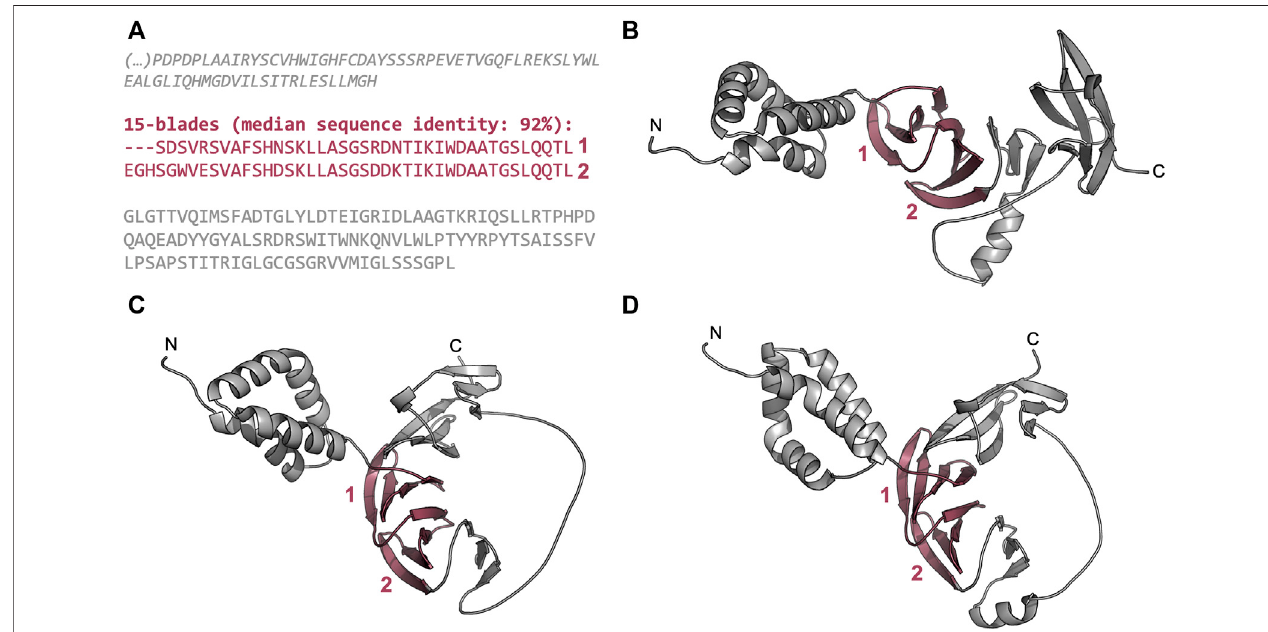
FIGURE 7 | The globally highly repetitive β -propeller of Menosporascus sp. CRB-9-2 hypothetical protein DL7770_005,219 (RYP84315.1). (A) Annotated β - propeller sequence, highlighting the two highly identical, consecutive blades and the fl anking non-propeller sequences. The individual strands in each β -propeller blade are highlighted in grey. (B – D) Three-dimensional models of the β -propeller and immediate fl anking regions predicted with AlphaFold v2.1.2 (Jumper et al., 2021). Modelling was carried out with the full-length protein sequence but only the region whose sequence is shown in (A) are depicted. (B) The top ranking model (QMEANDisCoGlobal(Studeretal.,2020)scoreof0.57±0.05,averagepLDDT(Jumperetal.,2021)of80.1), (C) thesecondbestmodel(QMEANDisCoGlobalscoreof 0.58 ± 0.05, average pLDDT of 75.9), and (D) the third best model (QMEANDisCo Global score of 0.58 ± 0.05, average pLDDT of 71.0).